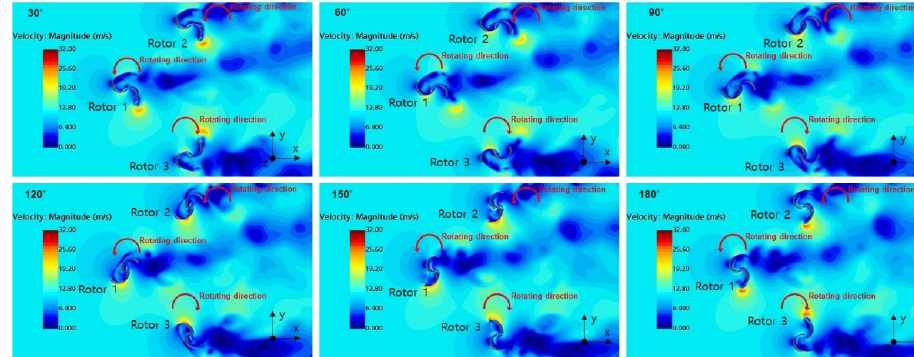
Figure 16. Velocity distribution according to rotor rotation position for three rotors in case 9.